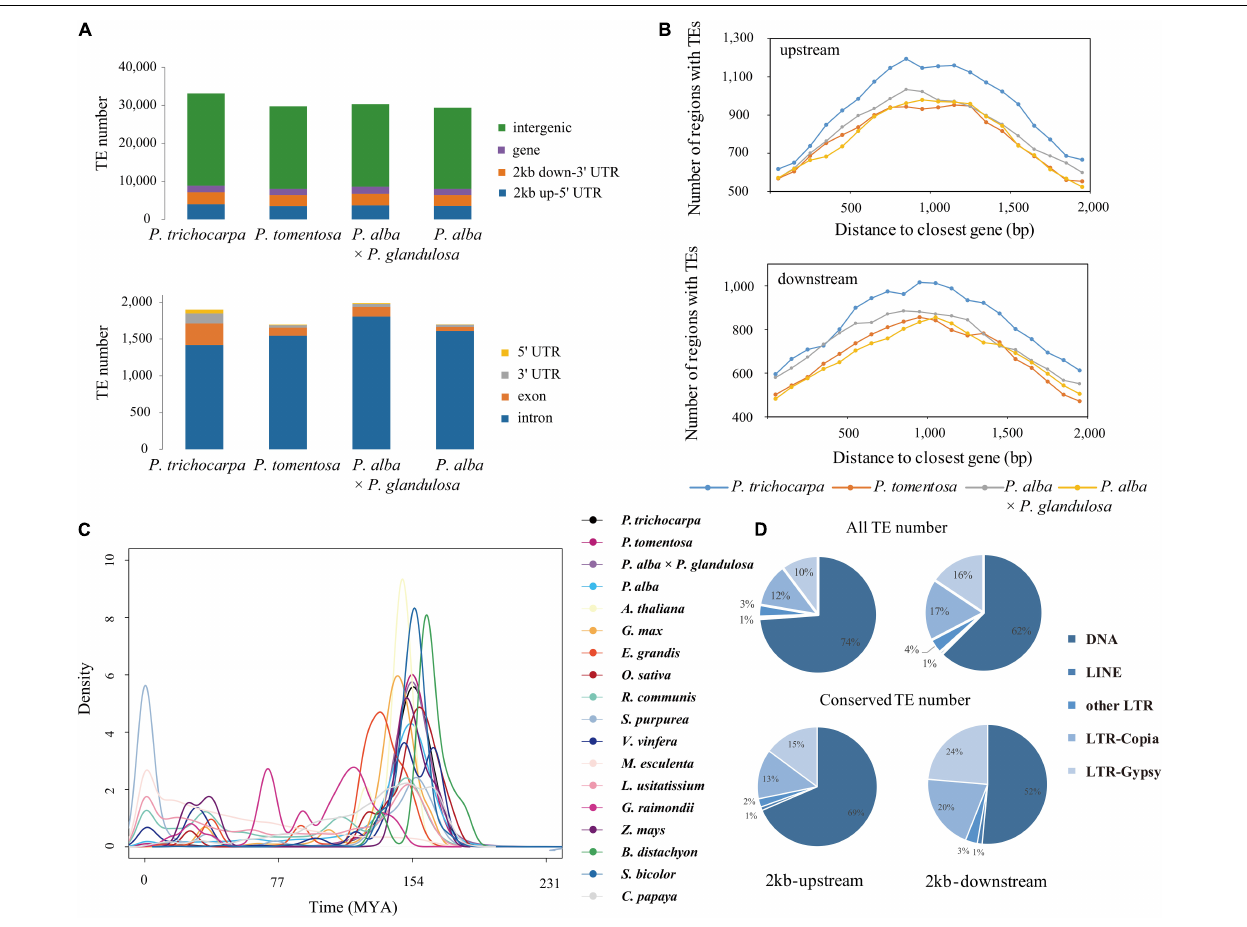
FIGURE 1 | Distribution of transposable elements in Populus . (A) Number of TEs in different genic regions of Populus trichocarpa, P. tomentosa, P. alba × P. glandulosa (84K), and P. alba genomes. (B) TEs enriched in 100-bp bins in the 2-kb upstream and 2-kb downstream region of genes between collinear gene pairs of P. trichocarpa, P. tomentosa, 84K, and P. alba . The x -axis represents the distance from TEs to the start codon (stop codon) of the nearest gene; the y -axis represents the number of TEs genes at different distances from the start codon (stop codon). (C) Density distributions of the Ks values for LTR transposons of 18 different species. (D) Distribution of transposable elements in P. trichocarpa of all TEs and conserved TEs (collinear TEs among four poplar genomes) in 2-kb upstream and 2-kb downstream